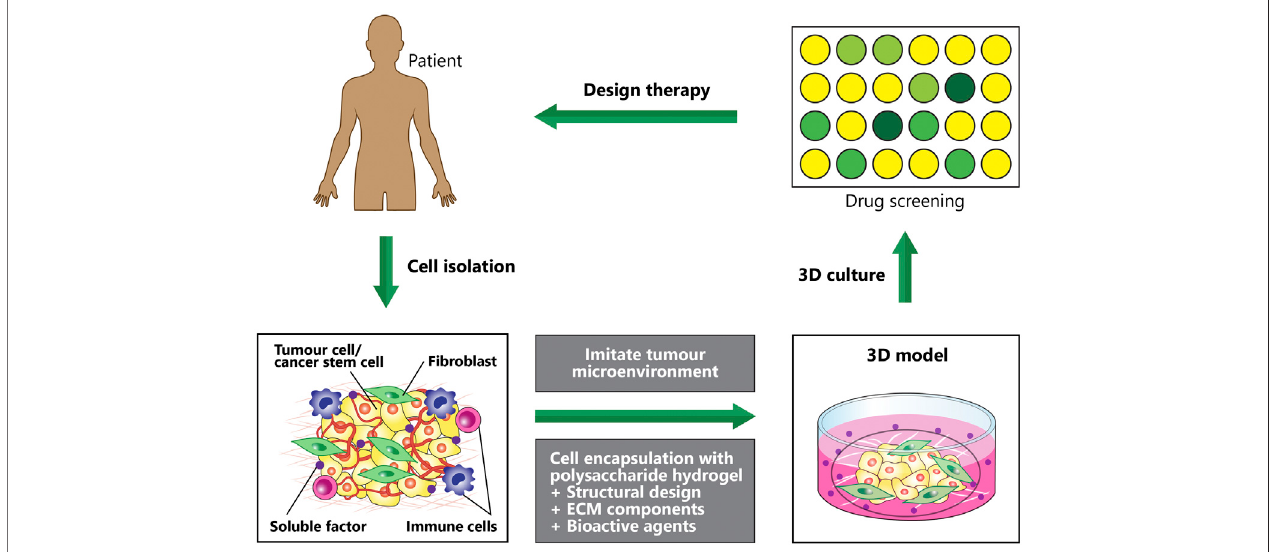
FIGURE 6 | Disease modeling: Creating 3D in vitro human tumour models to mimic various microenvironmental cues of human tumours, which can be used to screen anticancer therapeutics. Hydrogel fabrication and cell microencapsulation are involved in engineering the microenvironmental conditions. Impact of each condition on the ef fi cacy of the therapeutic approaches is determined by ef fi cient manipulation and regulation of the microenvironment conditions.